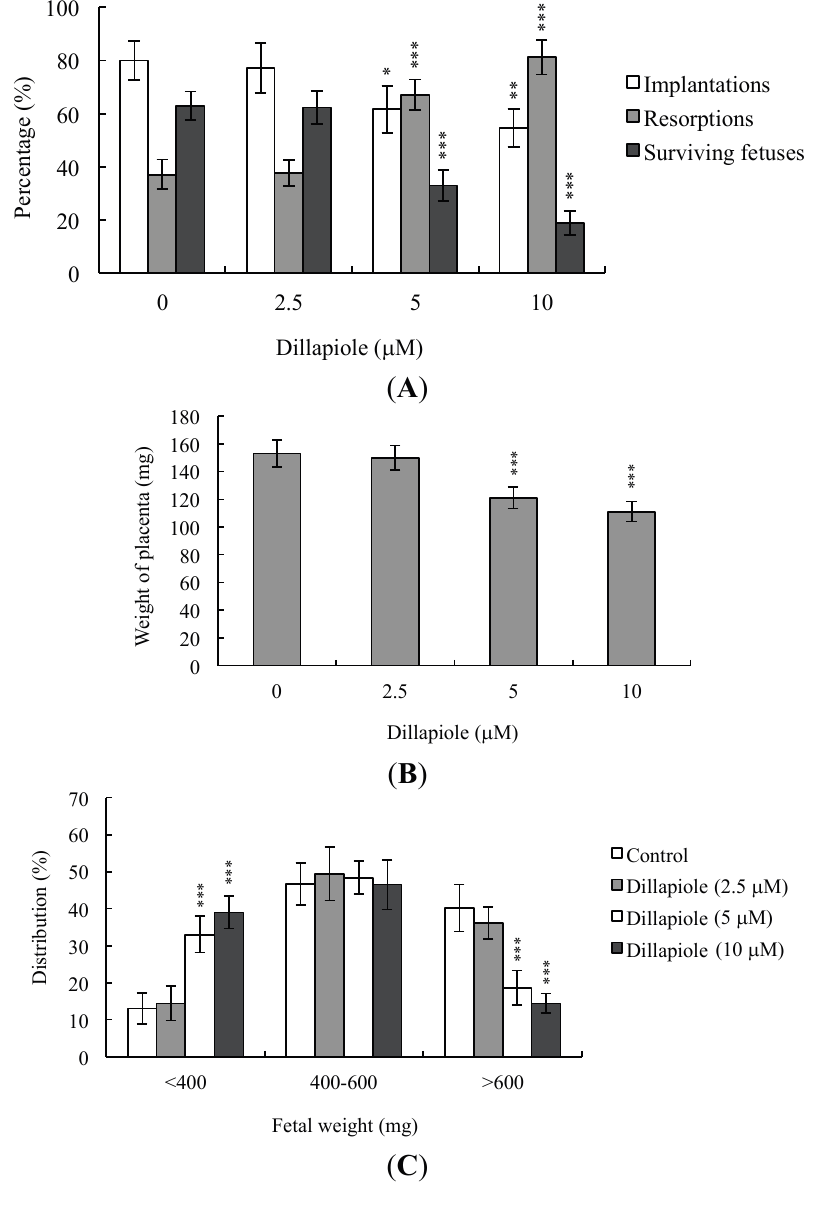
Figure 4. Effects of dillapiole on in vivo implantation, resorption, fetal survival and weight of mouse blastocysts. ( A ) Mouse blastocysts were treated with dillapiole (2.5, 5, or 10 μ M) or left untreated for 24 h. Implantations, resorptions, and surviving fetuses were analyzed as described in Materials and Methods. Results are expressed as percentages representing the number of implantations, resorptions or surviving fetuses per number of transferred embryos ×100. Data are based on 360 total blastocysts across 45 recipients; ( B ) Placental weights of 45 recipient mice were measured; ( C ) Weight distribution of surviving fetuses at day 18 post-coitus. Surviving fetuses were obtained via embryo transfer of control and dillapiole-pretreated blastocysts, as described in Materials and Methods (360 total blastocysts across 45 recipients). * p < 0.05, ** p < 0.01, and *** p < 0.001 versus the control